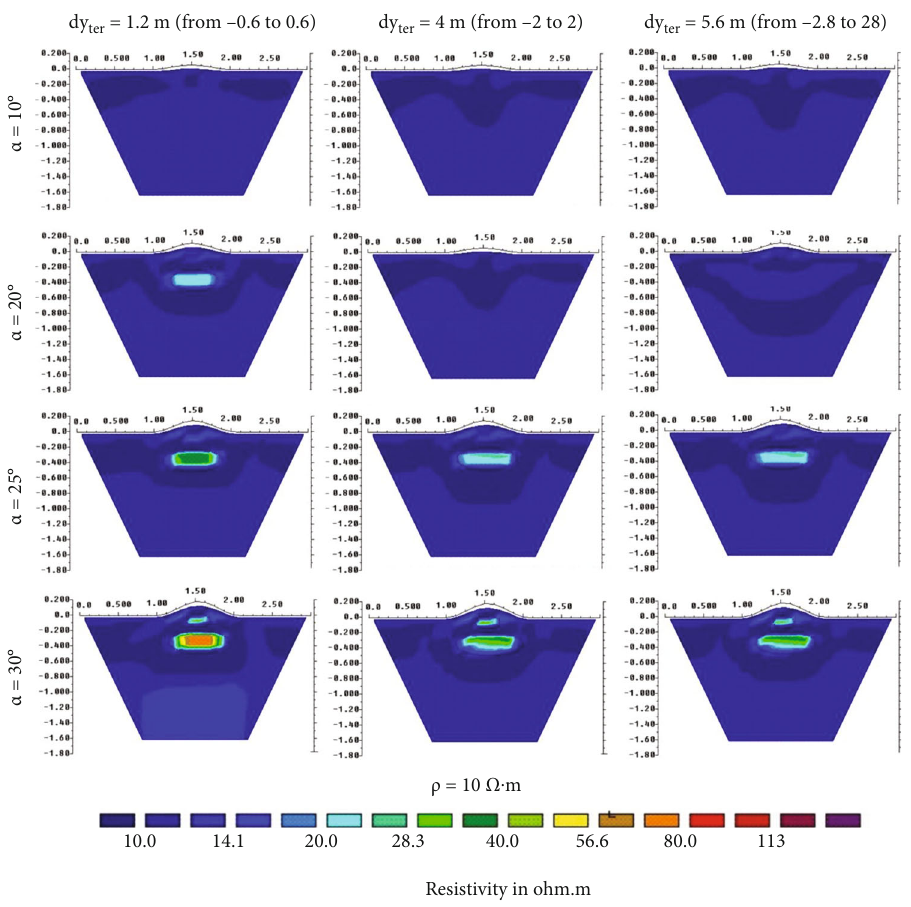
Figure 6: The in fl uence of the topography slope angle along the x -axis and the topography width of the 3D homogeneous medium in the Y- direction on the results of 2D